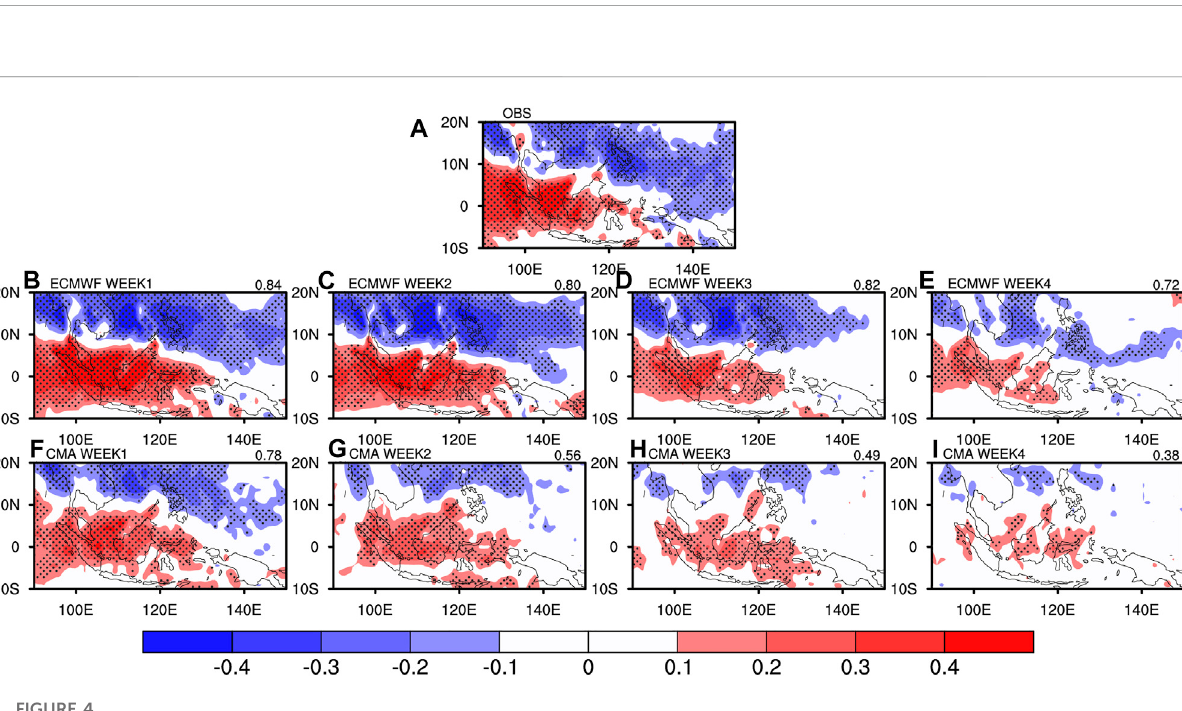
Spatial distribution of correlation coef fi cients between observed weekly mean precipitation anomalies and observed weekly mean OMI1 index (A) ,together with thecorrelation coef fi cients maps between forecasted weekly mean precipitation anomalies and forecasted OMI1 indexin ECMWF (B – E) and CMA (F – I) at the lead time of 1 – 4 weeks. The pattern correlation coef fi cients between observed correlation coef fi cients maps and forecasted correlation coef fi cients maps are also provided on the right strings. Stipples indicate correlations statistically signi fi cant at the 95%